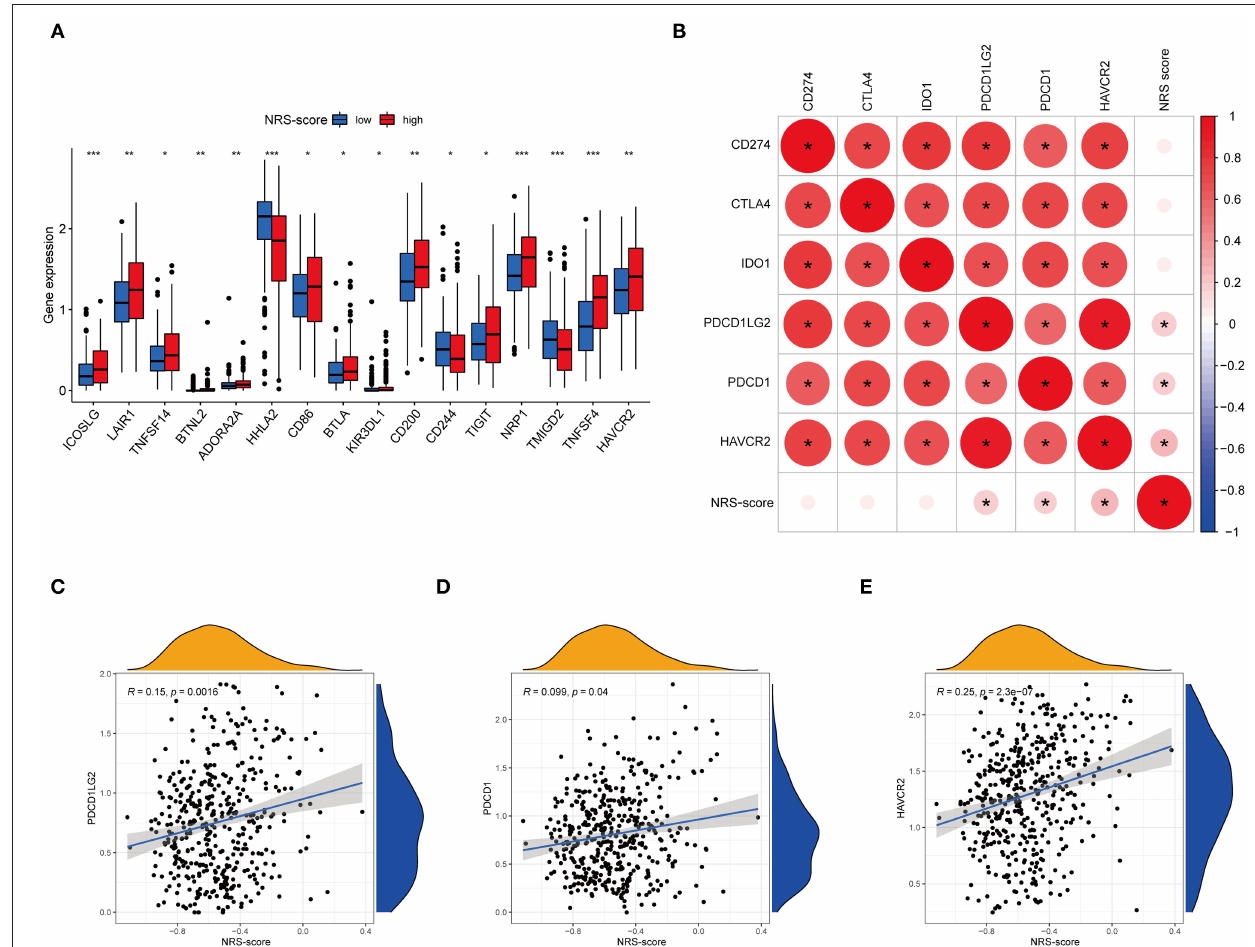
FIGURE 10 | Analysis of the correlation between NRS-score based prognostic signature and the key immune checkpoint genes. (A) Differential expression levels of the immune checkpoint resistance-related genes in the low NRS-score and high NRS-score groups (* P < 0.05, ** P < 0.01, and *** P < 0.001). (B) Association between immune checkpoint inhibitors CD274, PDCD1, CTLA4, PDCD1LG2, HAVCR2, and IDO1 with NRS-score. (C) Positive correlation between NRS-score and PDCD1LG2. (D) Positive correlation between NRS-score and PDCD1. (E) Positive correlation between NRS-score and